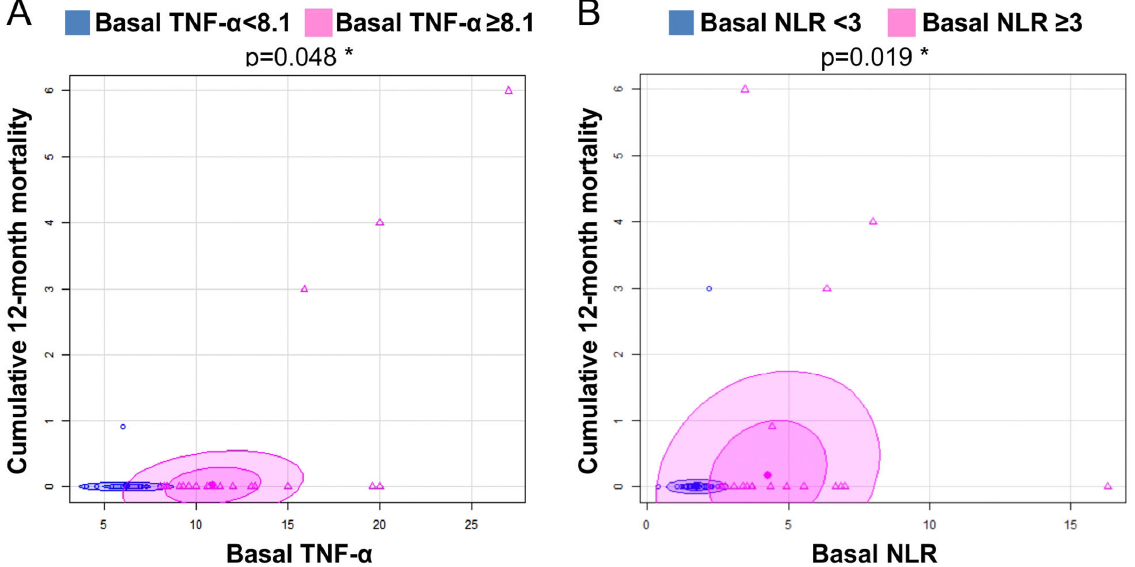
Figure 7. Cumulative 12-month mortality and plasma markers . ( A ). Basal TNF- α ; ( B ). Basal NLR (Neutrophil-to-lymphocyte ratio). * p < 0.05.